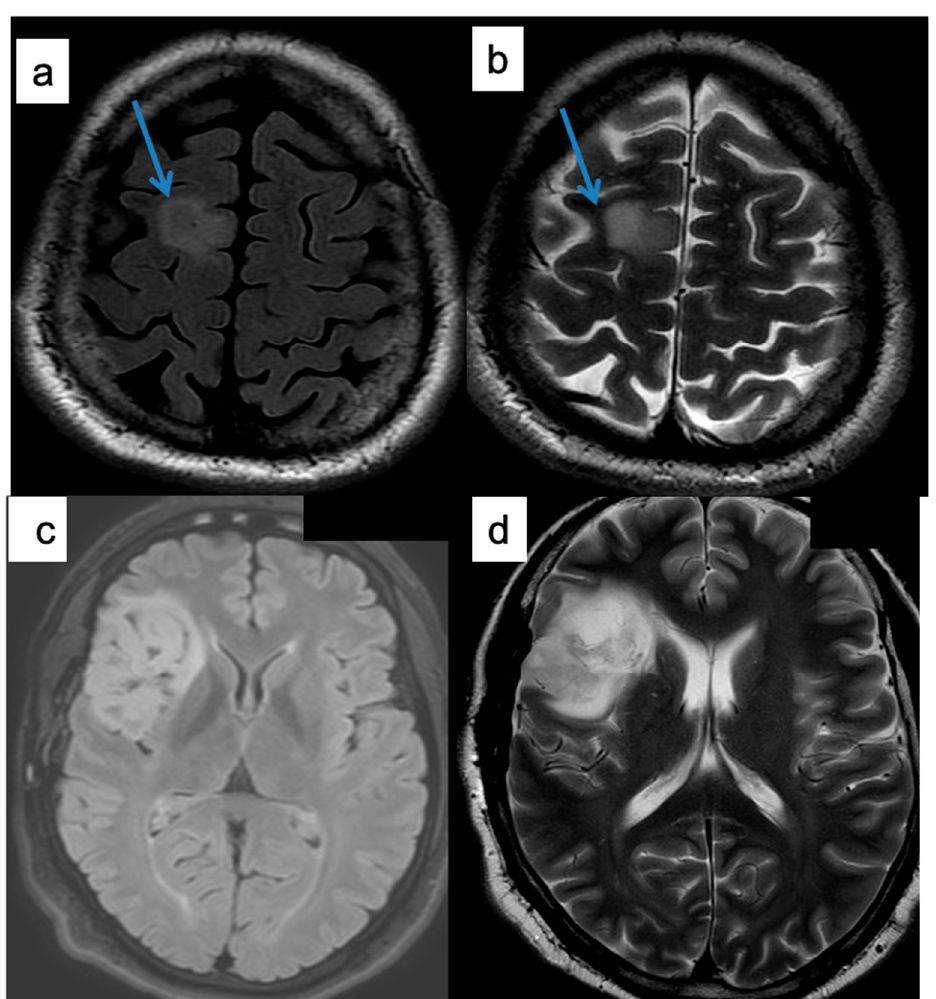
Figure 1. T2–FLAIR mismatch sign. ( a , c ) are fluid-attenuated inversion recovery (FLAIR) images while ( b , d ) are T2 weighted images (WI).